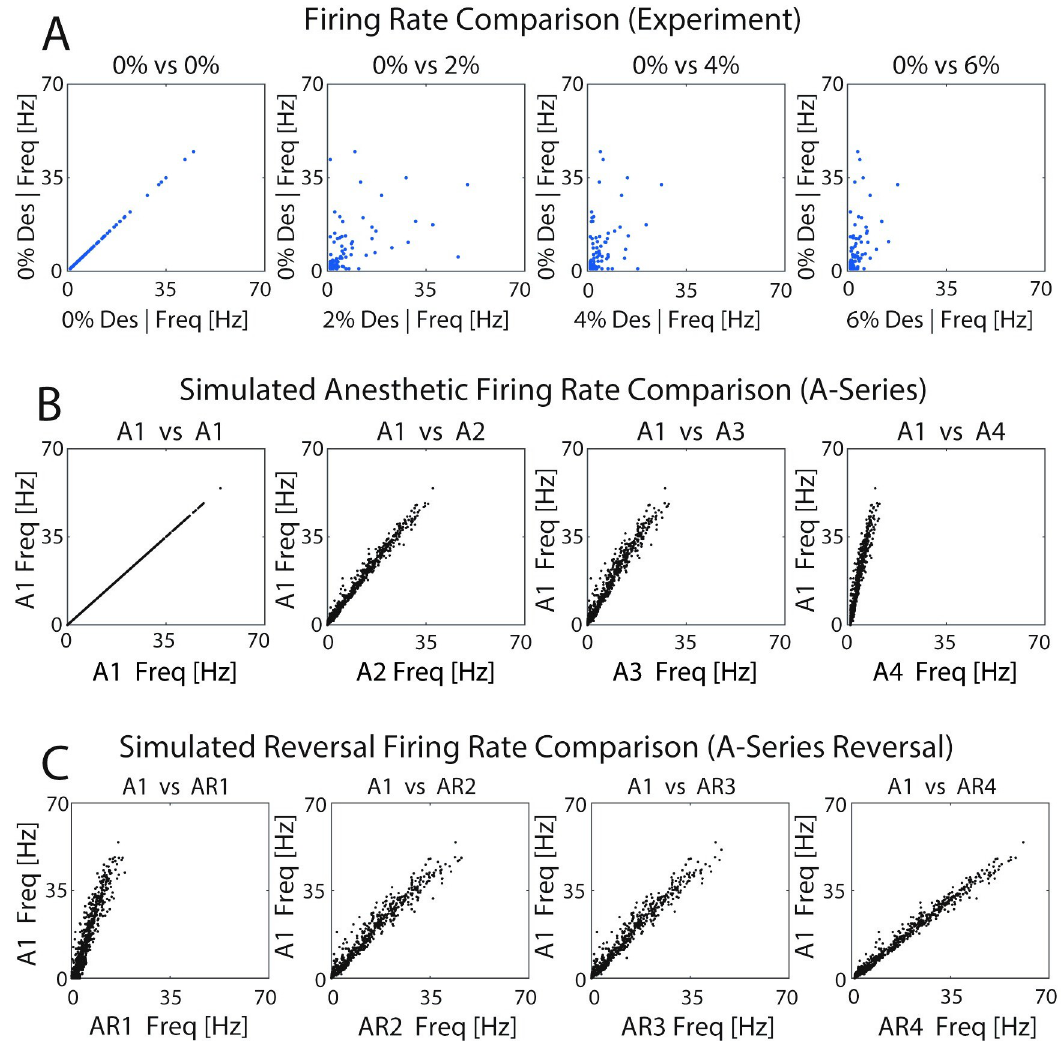
Fig 6. Effects of anesthetic concentration and simulated ACh-induced reversal on relative profiles of neuronal firing frequency. Each panel depicts the firing frequency of each neuron in a given anesthetic/reversal state (x-axis) compared to its firing frequency in the non-anesthetic condition (0% desflurane or A1) (y-axis) A) Units recorded in the experimental data; B,C) Neurons in A-series optimized networks and reversal.